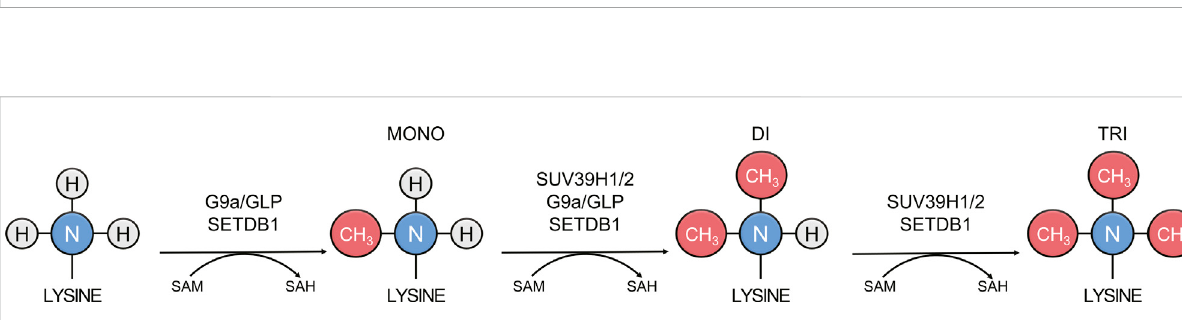
FIGURE 3 Methylation states catalyzed by main mammalian H3K9 methyltransferases. SUV39H1, SUV39H2, SETDB1, SETDB2, G9a, and GLP transfer methyl groups (red) from cofactor SAM to the epsilon nitrogen (blue) of lysine residues to create mono-, di-, and